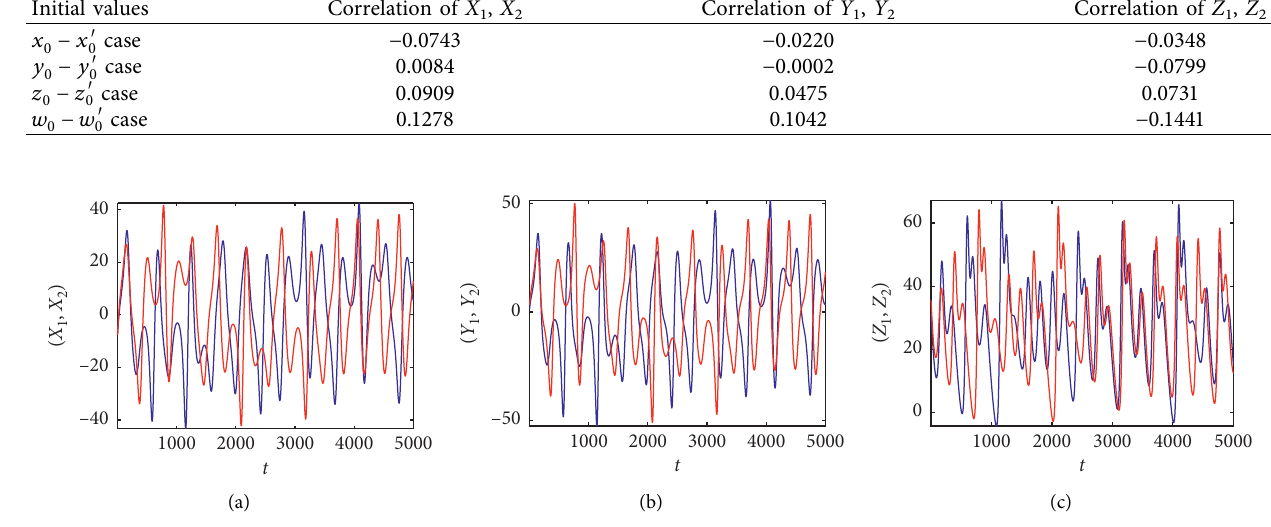
Figure 11: The timing diagrams of different sequence pairs of under [ x ,Z ) ( Z 1 2